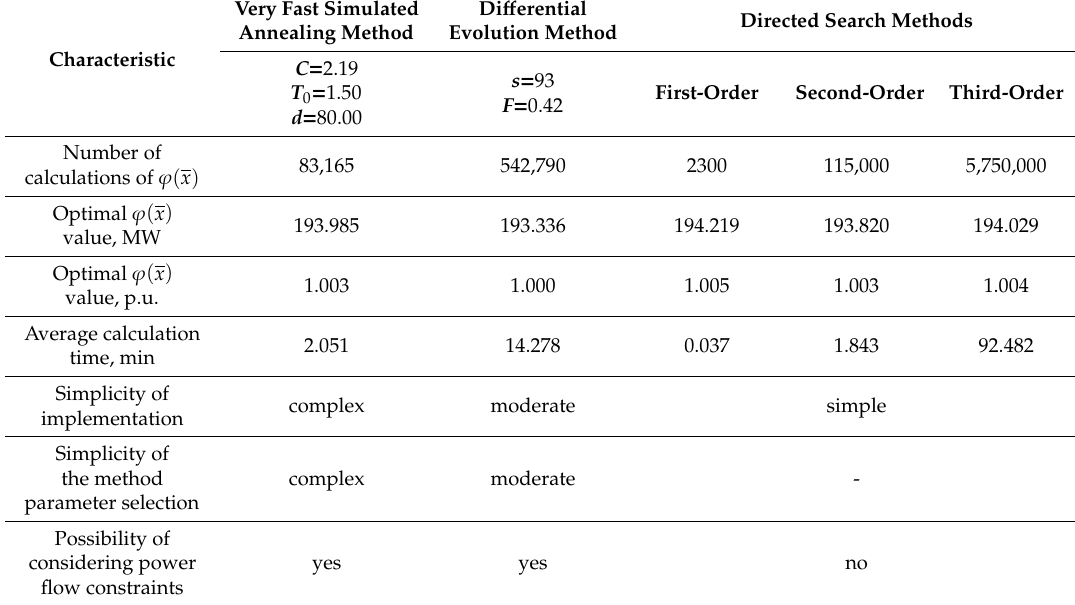
Table 7. Maintenance scheduling results for the third test